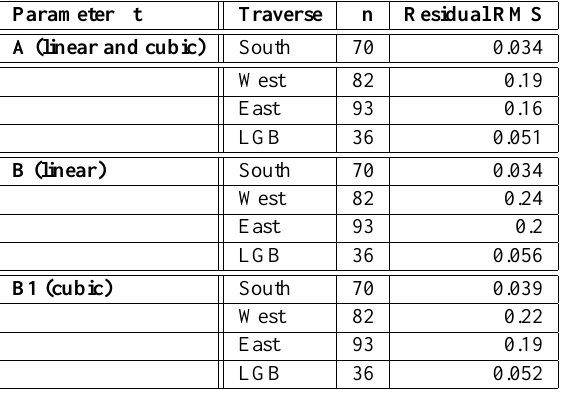
Table 1: RMS residual of individual least-squares fits for each traverse route. Parameter